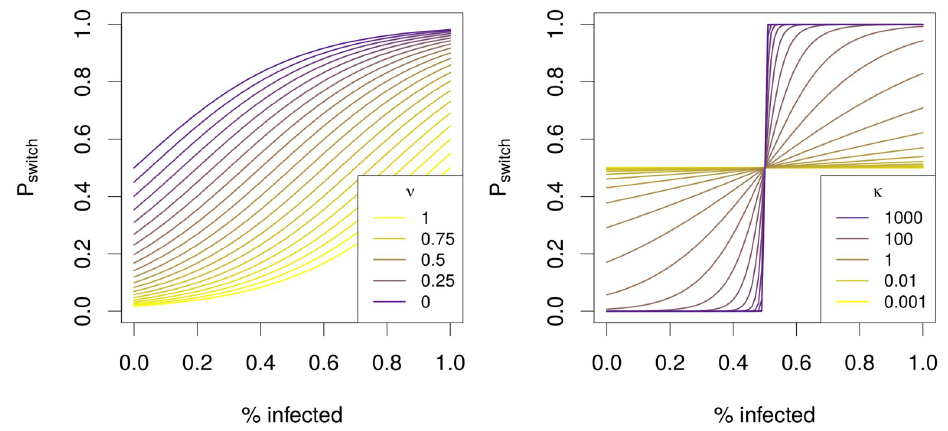
Fig 2. Illustration of the impact of transparency of choice, κ , and point of inflection, ν , on the decision curve.